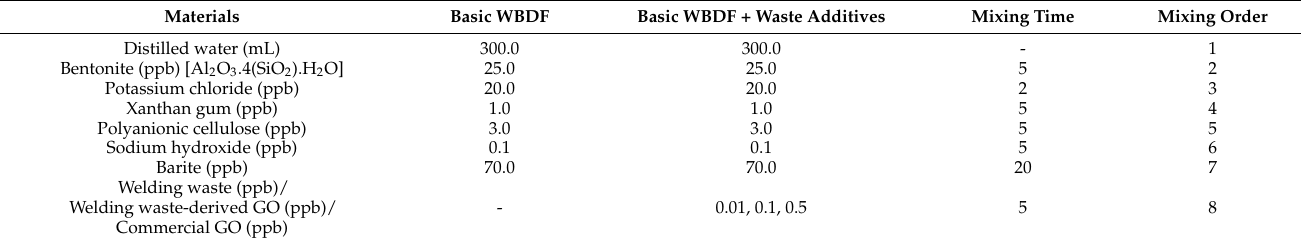
Table 1. Formulations of